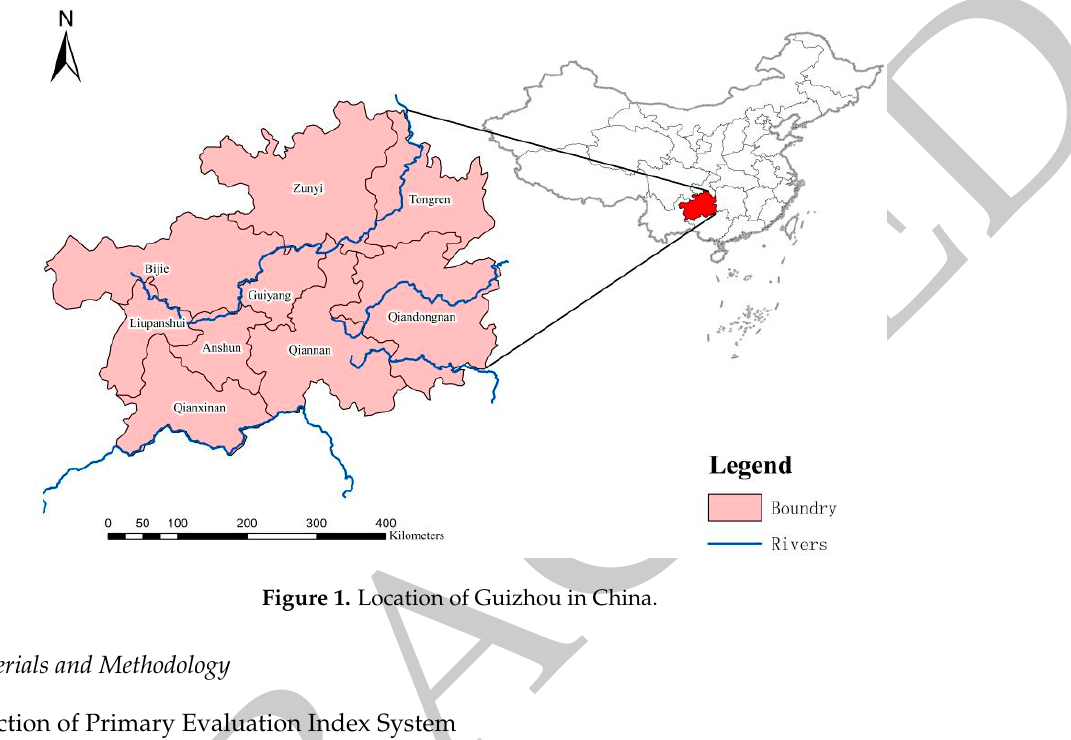
Figure 1. Location of Guizhou in China.